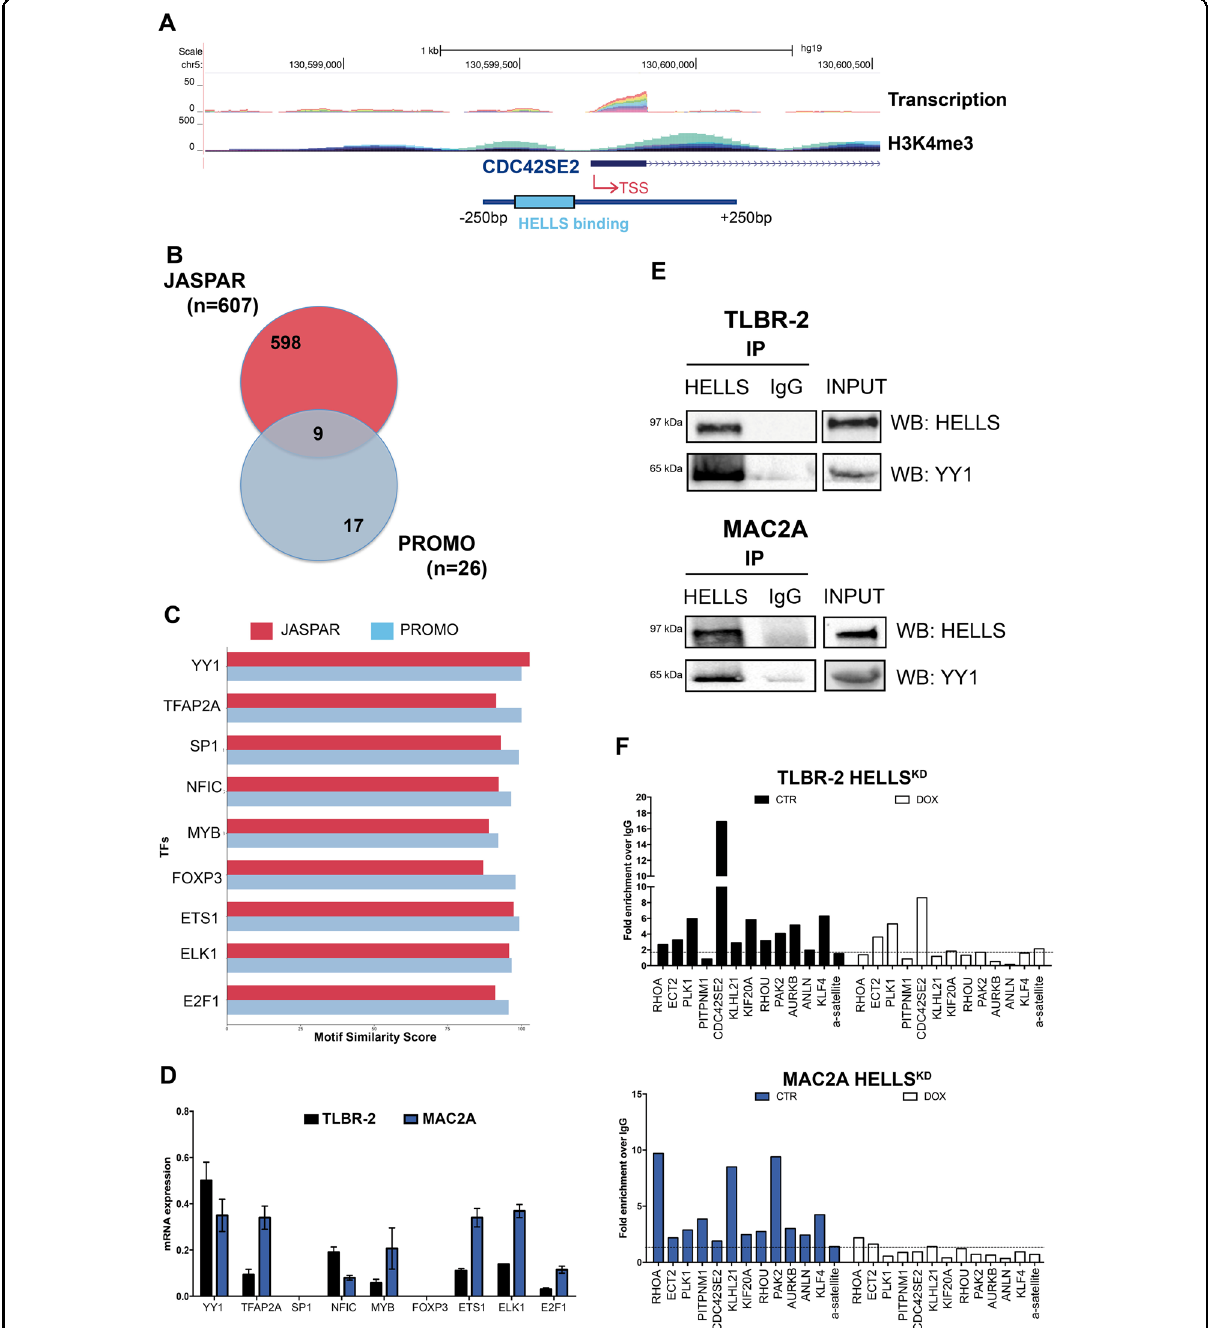
Fig. 3 HELLS interacts with the transcriptional factor YY1. A Schematic representation of CDC42SE2 genomic locus showing the position, the level of transcription and the enrichment of H3K4me3 on its putative promoter. B The Venn diagram represents the intersection between transcriptional factors (TFs) identi fi ed by JASPAR ( n = 607) and PROMO ( n = 26) TFs binding prediction tools. The intersection shows the number of HELLS-predicted and common TFs ( n = 9). C JASPAR and PROMO similarity scores are represented for top-ranked enriched transcription factors (TFs). D qRT-PCR analysis of top scoring TFs in TLBR-2 and MAC2A cell lines. Each data represent mean ± SEM ( n = 3). E Nuclear extract from TLBR-2 and MAC2A cells were tested for the presence of a multi-protein complex. Co-immunoprecipitation experiments were performed to evaluate binding of HELLS to YY1. Western blots are representative of two independent experiments. F ChIP qRT-PCR detection of YY1 in TLBR-2 HELLS KD and MAC2A HELLS KD after 48 h of doxycycline (DOX) induction. KLF4 and α -satellite were used as positive and negative controls, respectively. The values represent the fold enrichment over IgG (representative of three independent